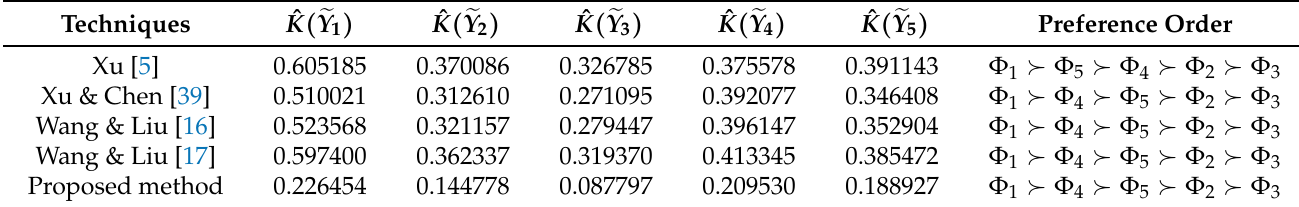
Table 6. Comparative assessment using a few popular methodologies.